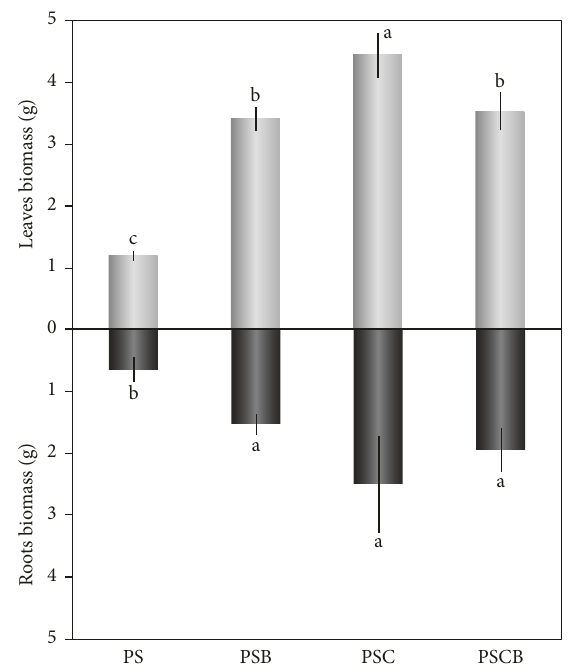
Figure 3: Effects of biochar and/or compost on leaf and root biomass (g of dry tissue weight) . Data represent the mean ( 𝑛 = 6 ) ± standard error. Mean values marked with the same letter are not statistically different. One-way ANOVA was applied to weigh the effects of different treatments ( 𝑝 ≤ 0.05 ). PS = lettuce plants grown in unfertilized soil; PSB = lettuce plants grown in unfertilized soil plus biochar; PSC = lettuce plants grown in unfertilized soil plus compost; and PSCB = lettuce plants grown in unfertilized soil plus compost and